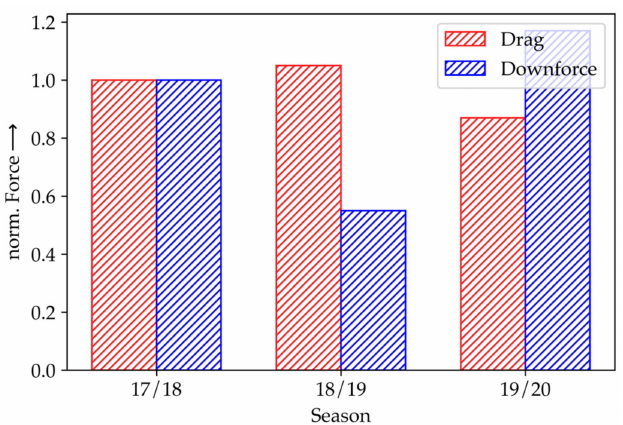
Figure 6. KPIs “drag” and “downforce” of final designs from the last three seasons. Without the possibility of more than one design iteration per season, the team was not able to mitigate setbacks such as those in the 18/19 season.